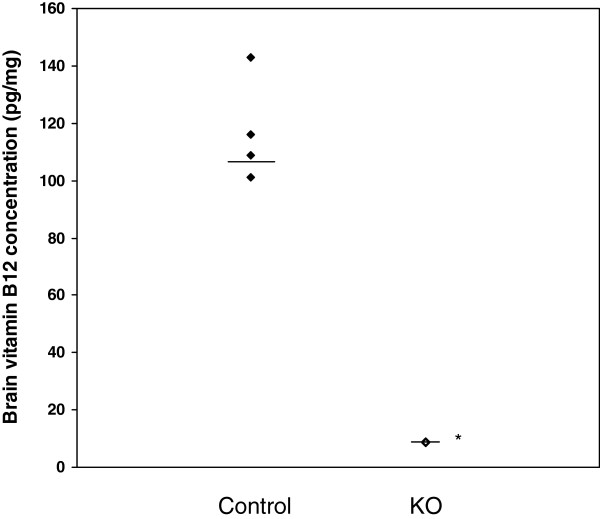
Vitamin B12concentration in control and TCblR/CD320KO mouse brain. Lines in graph represent the medians. *Mann Whitney U test, compared to control mice, p < 0.05, (n = 4).